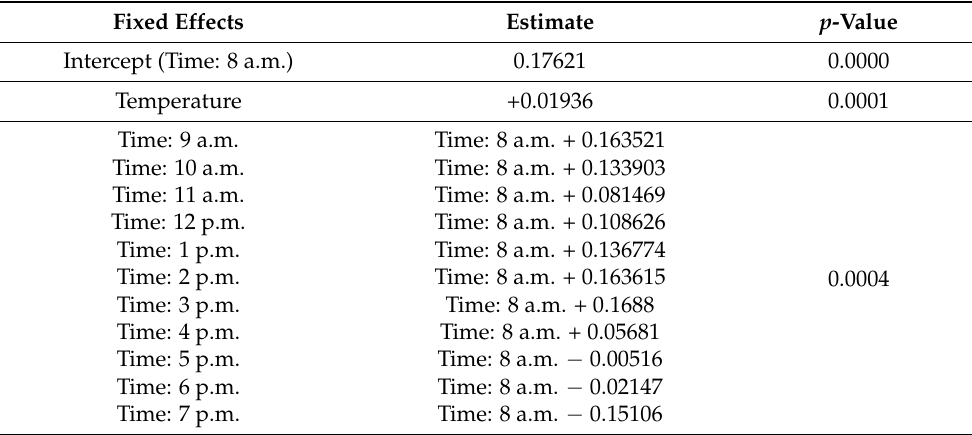
Table 4. Results from the application of linear mixed-effect models, including temperature and the hour at which the sample was taken, as fixed